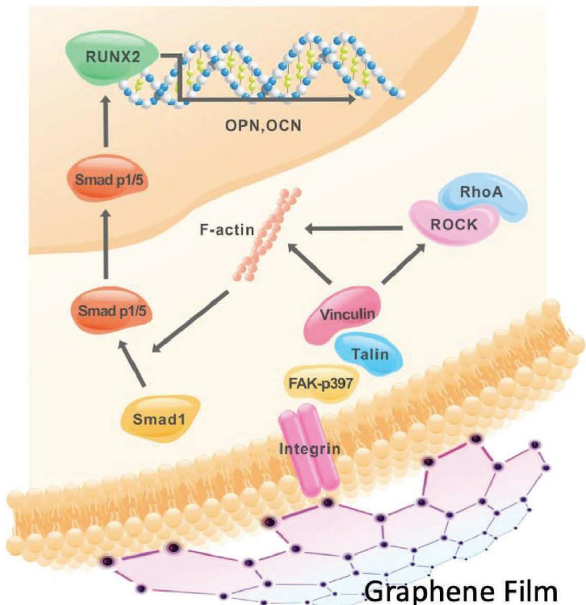
Figure 11: Integrin/FAK mechano-transduction pathway induced by graphene flms (reprinted with permission from Xie et al. [109] following the Creative Commons Attribution (CC BY) license (https://creativecommons.org/licenses/by/4.0/) (accessed on 4 May